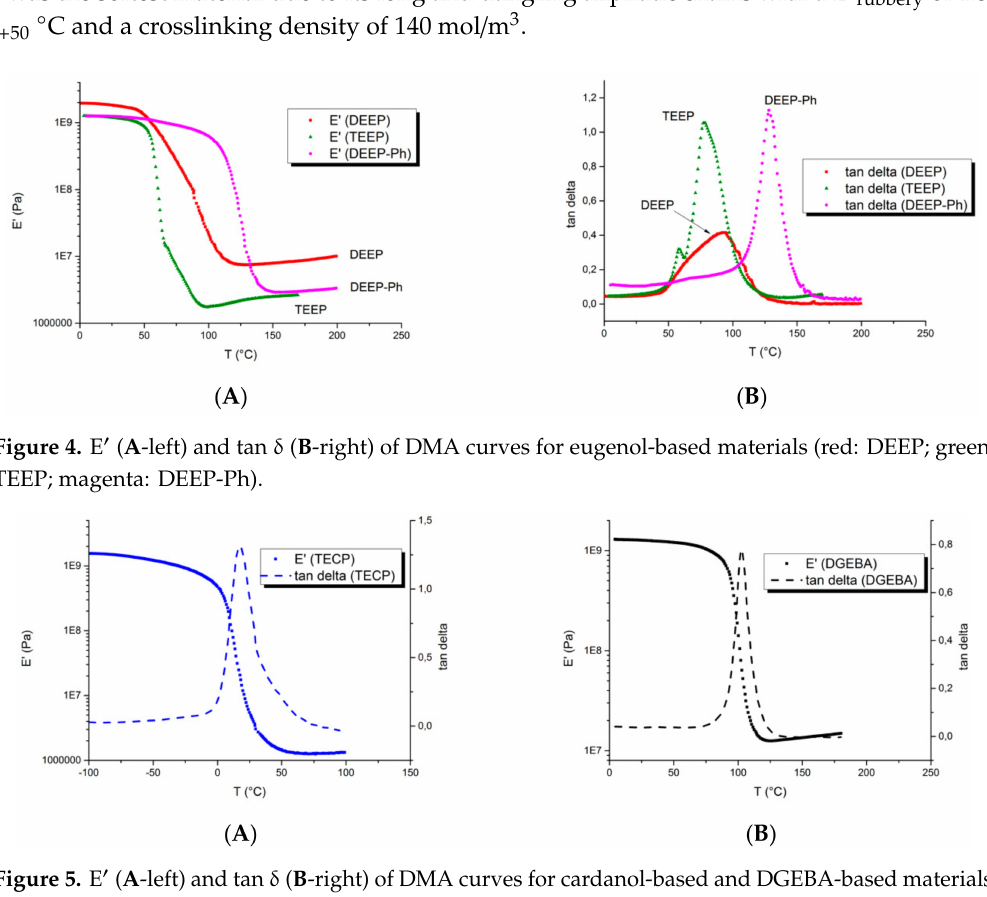
Figure 5. E (cid:48) ( A -left) and tan δ ( B -right) of DMA curves for cardanol-based and DGEBA-based materials (blue: TECP; black: DGEBA).